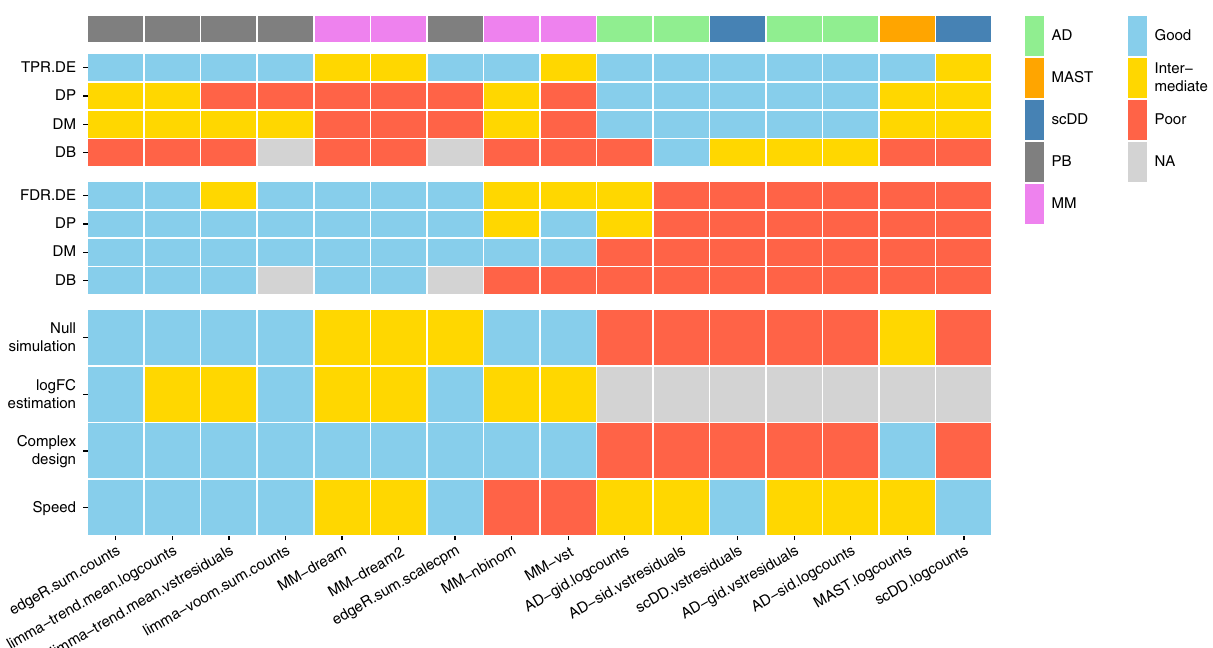
Fig. 5 Summary of DS method performance across a set of evaluation criteria. Methods are ranked from left to right by their weighted average score across criteria, with the numerical encoding good = 2, intermediate = 1, and poor/NA = 0. Evaluation criteria ( y -axis) comprise DS detection sensitivity (TPR) and speci fi city (FDR) for each type of differential distribution, uniformity of p value distributions under the null (null simulation), concordance between simulated and estimated logFCs (logFC estimation), ability to accommodate complex experimental designs (complex design), and runtimes (speed). Top annotation indicates method types (PB pseudobulk (aggregation-based) methods, MM mixed models, AD Anderson – Darling tests). Null simulation, logFC estimation, complex design, and runtimes received equal weights of 0.5; TPR and FDR were weighted according to the frequencies of modalities in scRNA-seq data reported by Korthauer et al. 33 : ~75% unimodal, ~5% trimodal, and ~25% bimodal, giving weights of 0.75 for DE, 0.125 for DP and DM, and 0.05 for